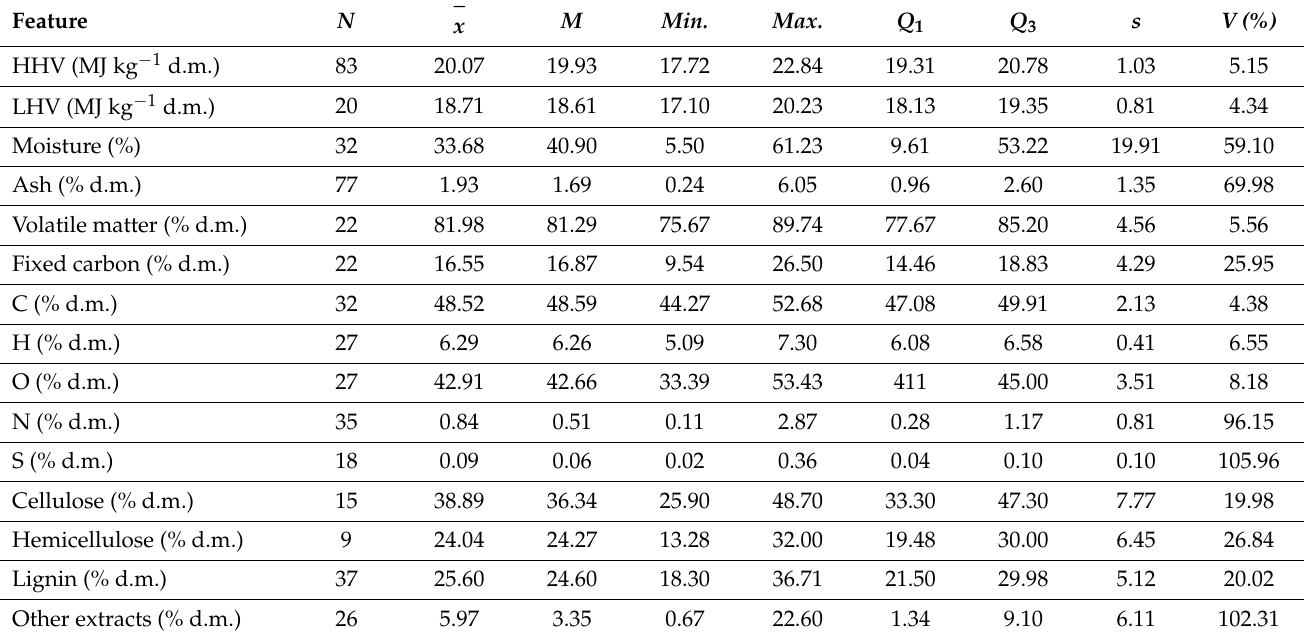
Table 4. Differentiation of thermophysical properties and elemental composition of branches without differentiation by